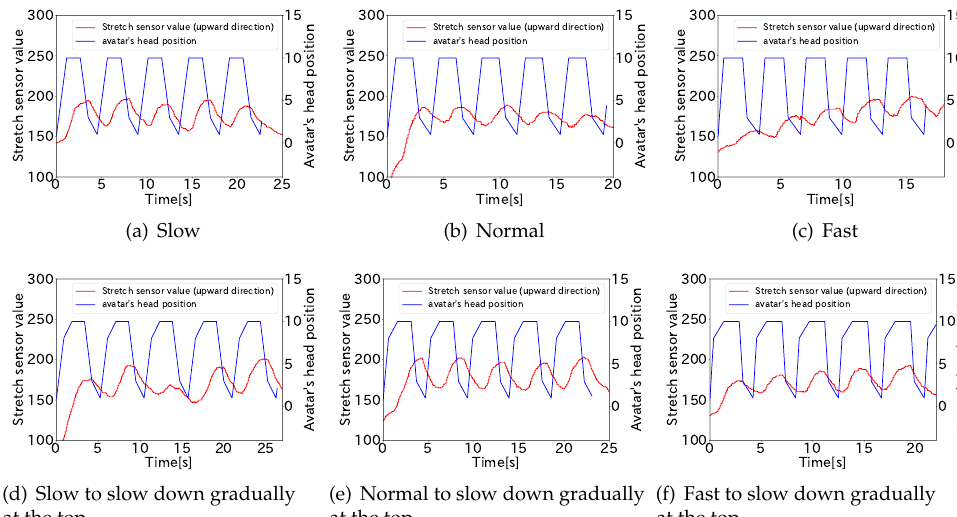
Figure A1. Stretch sensor values at each stretch speed in the upward direction (Participant B).